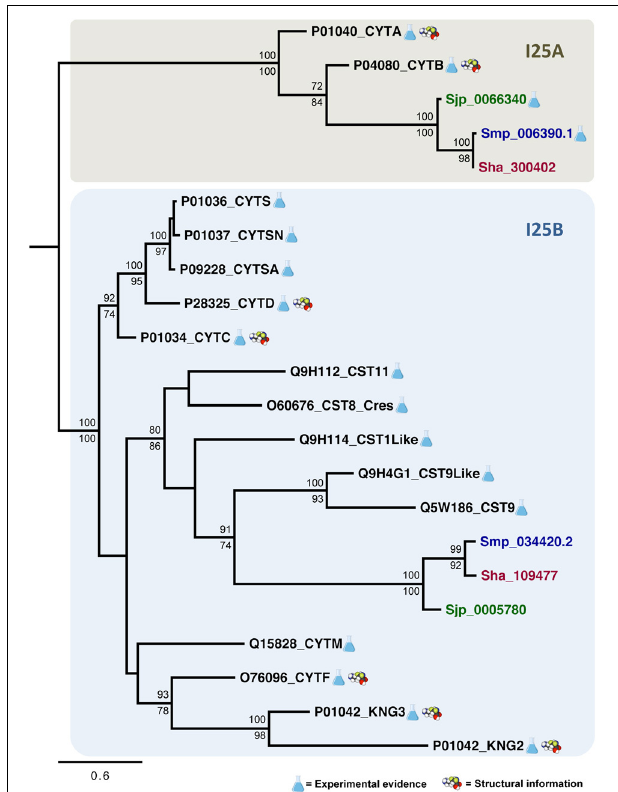
FIGURE 4 | Evolutionary relationships of I25A and I25B cysteine protease inhibitors. A total of 22 amino acid sequences and 96 sites comprising the conserved domain (PF00031) of homologs encoded by S. haematobium (brown), S. japonicum (green), S. mansoni (blue), and Homo sapiens (black) were analyzed. The phylogeny was reconstructed by two methods using WAG was as the best fit model. In the Bayesian inference, support values for each node were estimated as posterior probability (above). In the maximum likelihood analysis, they were estimated using the Akaike Likelihood Ratio Test (aLRT) (below). Only support values higher than 70% are shown.